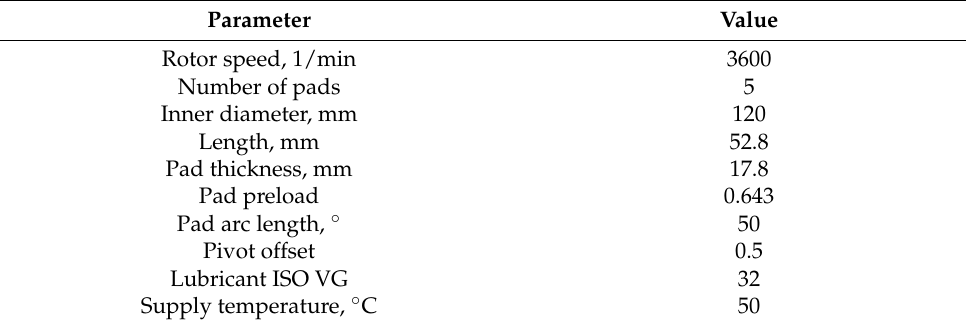
Table 1. Parameter of the 5-tilting-pad bearing.